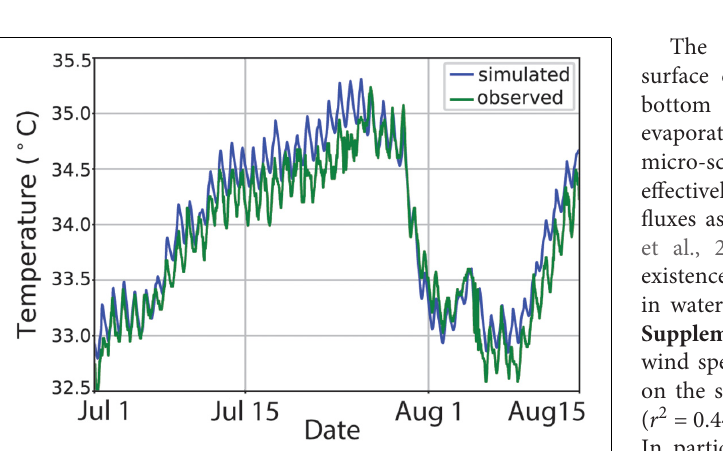
FIGURE 3 | Simulated (blue) and observed (green) bottom temperature at Saadiyat reef during summer 2013 showing a clear diurnal